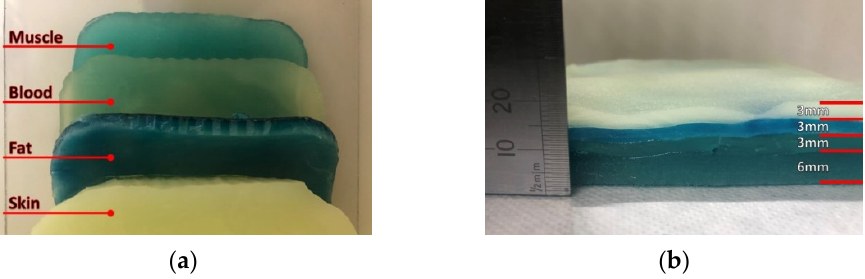
Figure 5. Realized multi-layer biological phantom: ( a ) top view and ( b ) side view.